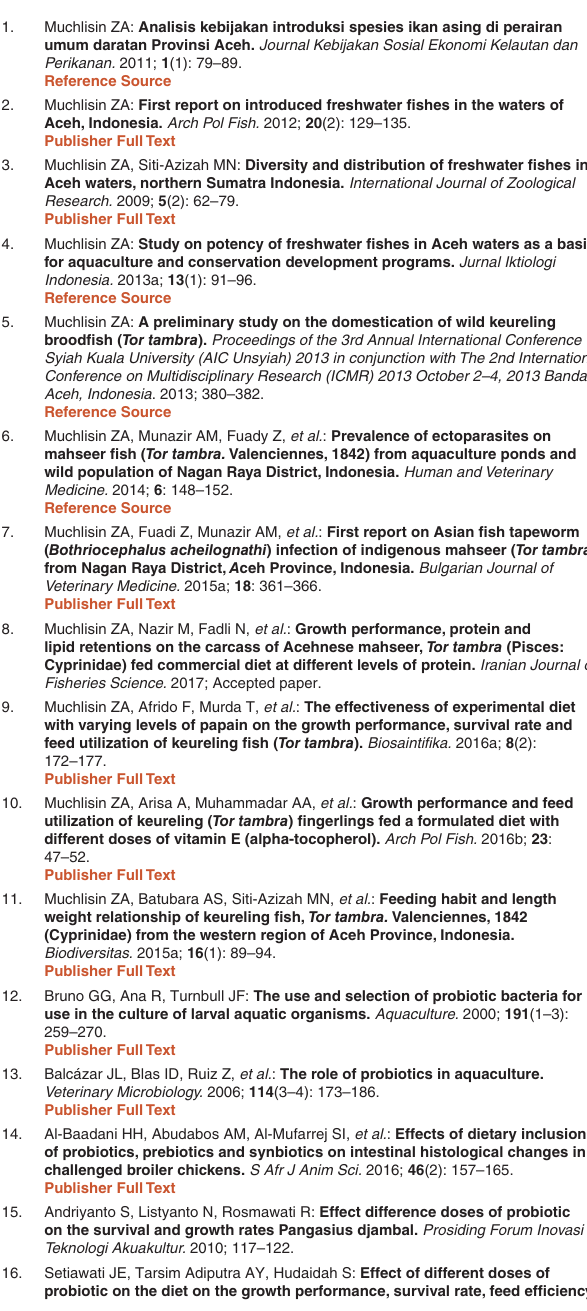
Supplementary Figure 1: Completed ARRIVE guidelines checklist. Click here to access the